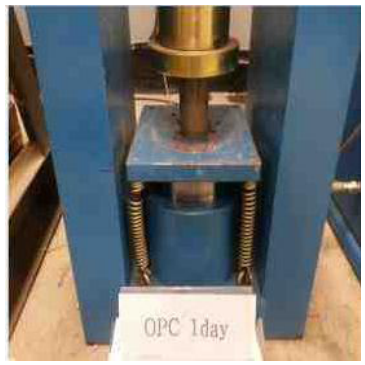
Figure 3. Test on formed OPC specimens.